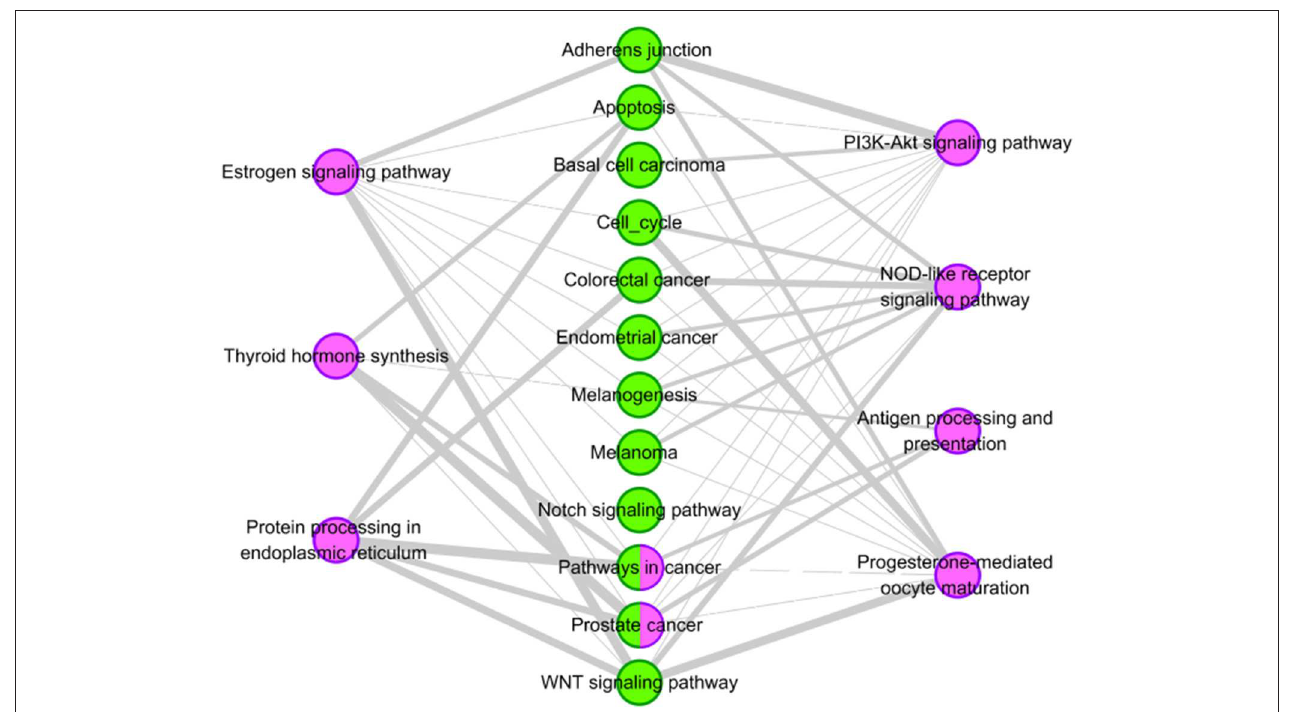
FIGURE 6 | Pathway analysis of rifabutine. The purple circles represent pathways of the rifabutine, and the green circles represent tissue-specific KEGG pathways of HCC. Nodes with two colors represent overlapping pathways for rifabutine and HCC. The gray edges indicate that there are common genes between two pathways, and the more genes there are, the wider the edges in the network.